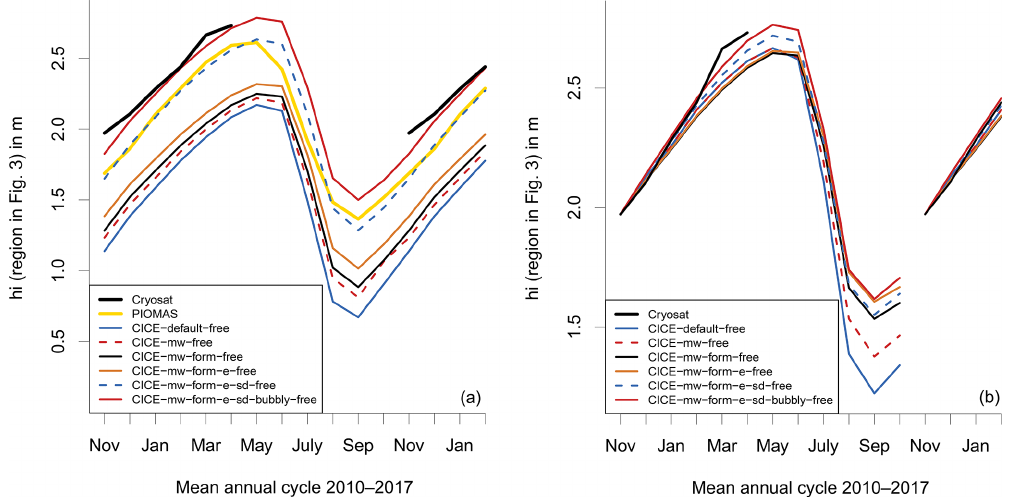
Figure 1. Impact of CICE set-up on mean effective sea ice thickness over the region shown in Fig. 3 and averaged over winter periods 2010/11 to 2016/17: (a) CICE-free simulations (multi-year runs from 1980 to 2017) and (b) CICE-ini simulations (seven 1-year-long runs starting in mid-November with CS2 sea ice thickness). Model results are compared with mean sea ice thickness from CS2 CPOM and PIOMAS. Effective ice thickness (divided by ice concentration) is presented. For CS2 ice concentration is applied from CICE-default (mean values for November to April vary between 99.4% and 99.8%). See Sect. 3.3.1 for explanation of CICE% experiments. Note that results for November, December, January, and February are shown twice for improved visualization of the annual cycle.